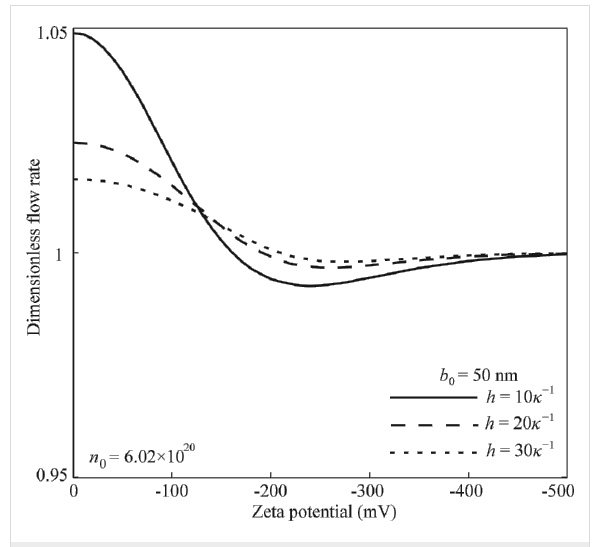
Figure 7: The effect of EDL with high zeta potential on the flow rate of the pressure-driven flow in the microchannel with slip